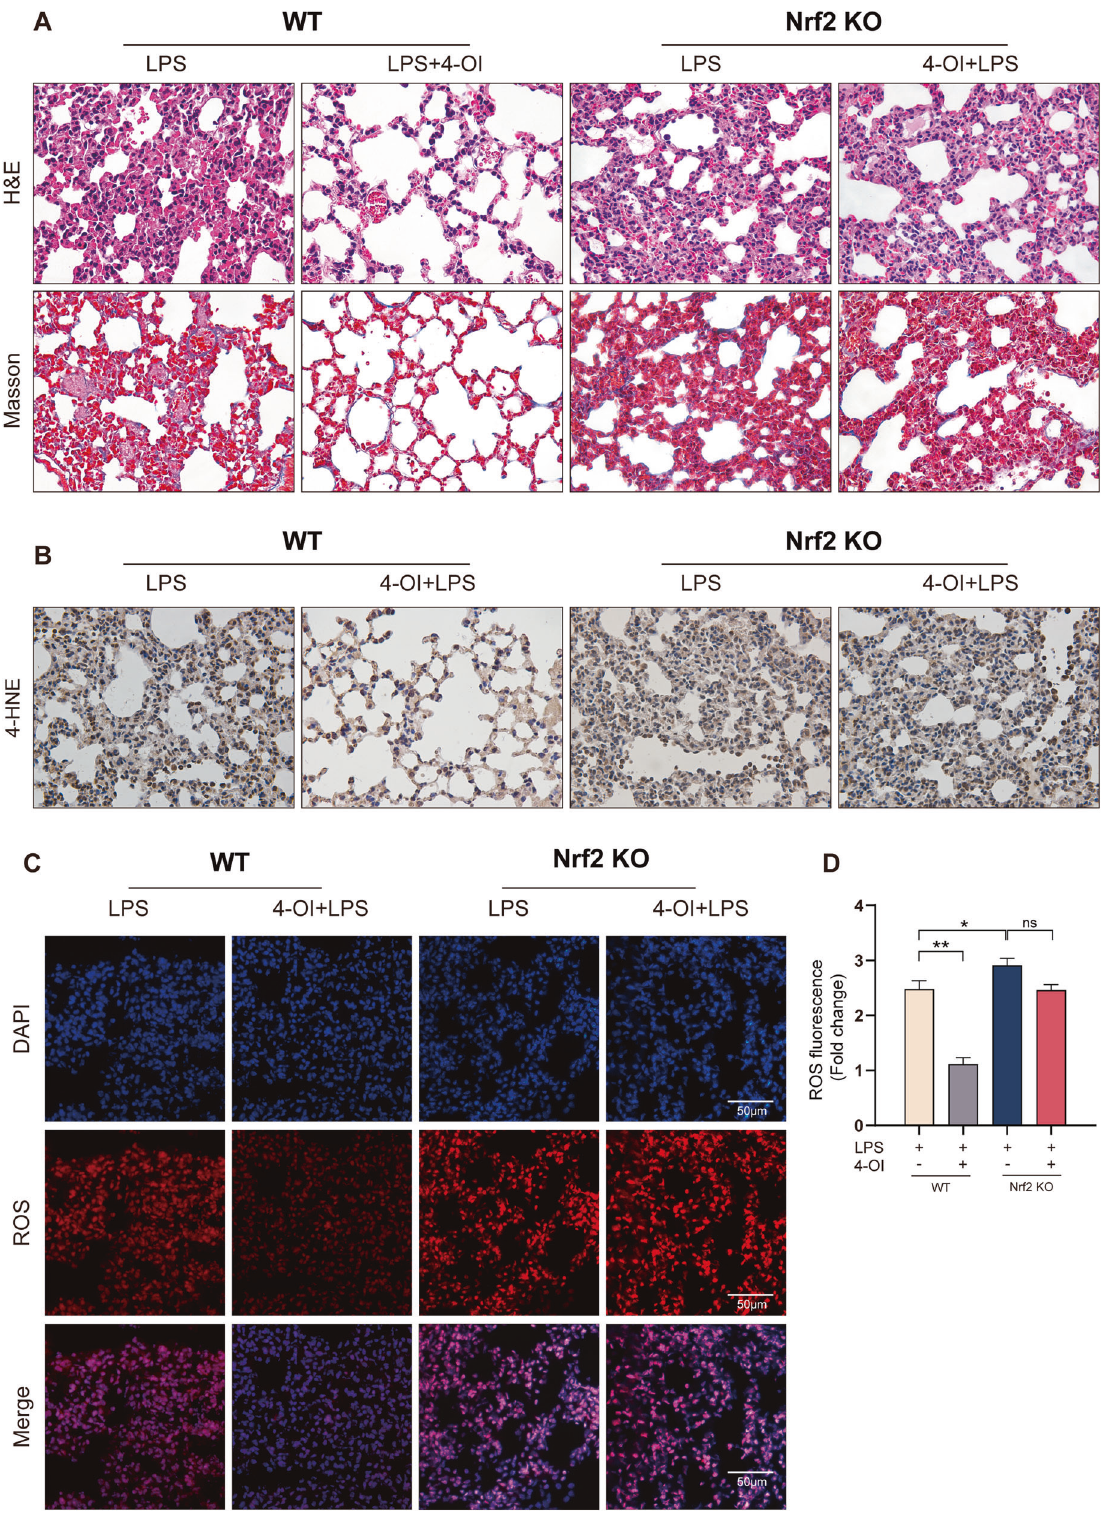
Fig. 5 The protection of 4-OI for sepsis-induced ALI was abolished in Nrf2-KO mice. A Representative images of H&E and Masson staining of murine lung tissue. B Representative images of immunohistochemistry staining for 4-HNE in murine lung tissue. C , D Representative images of fl uorescence probe for ROS and its quantitative results in murine lung tissue ( n = 6). (Data are presented as Mean ± SD * p < 0.05, ** p < 0.01, *** p < 0.001).